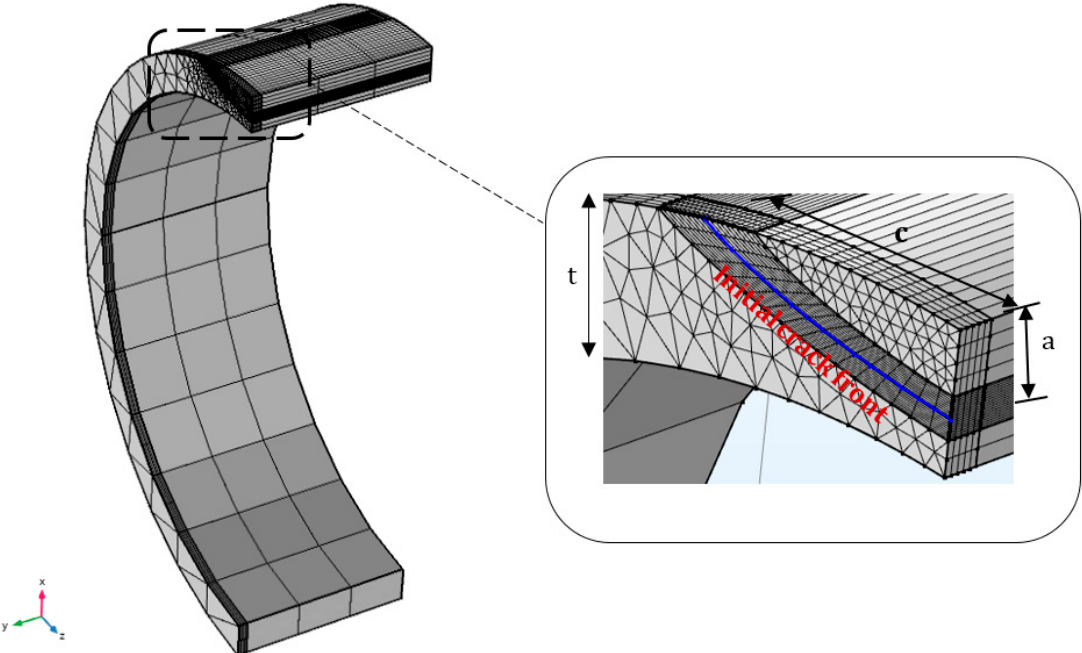
Figure 12. Pipe mesh with a detailed view of the mesh refinement in the crack region .